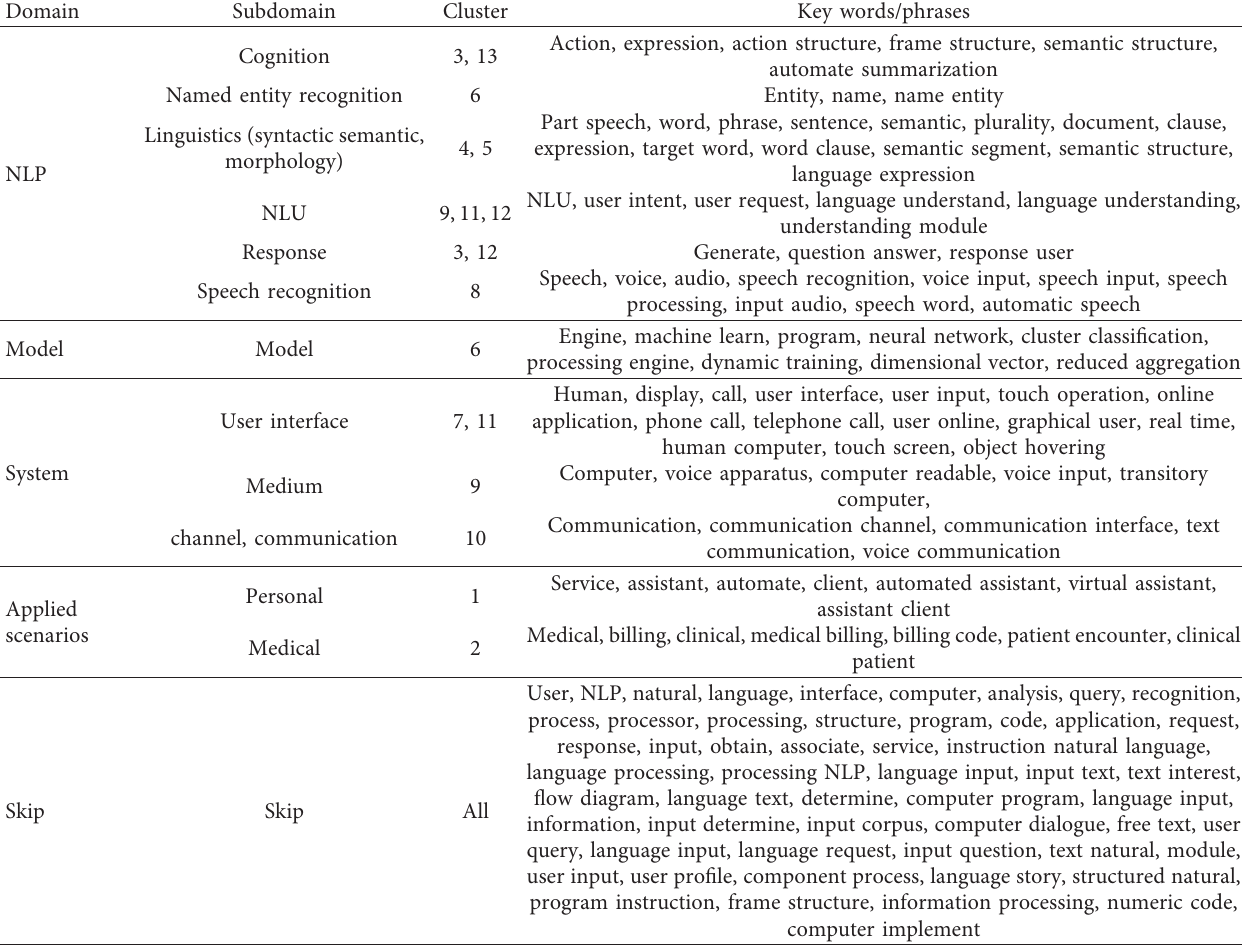
Table 4: Domains, subdomains, and terms.